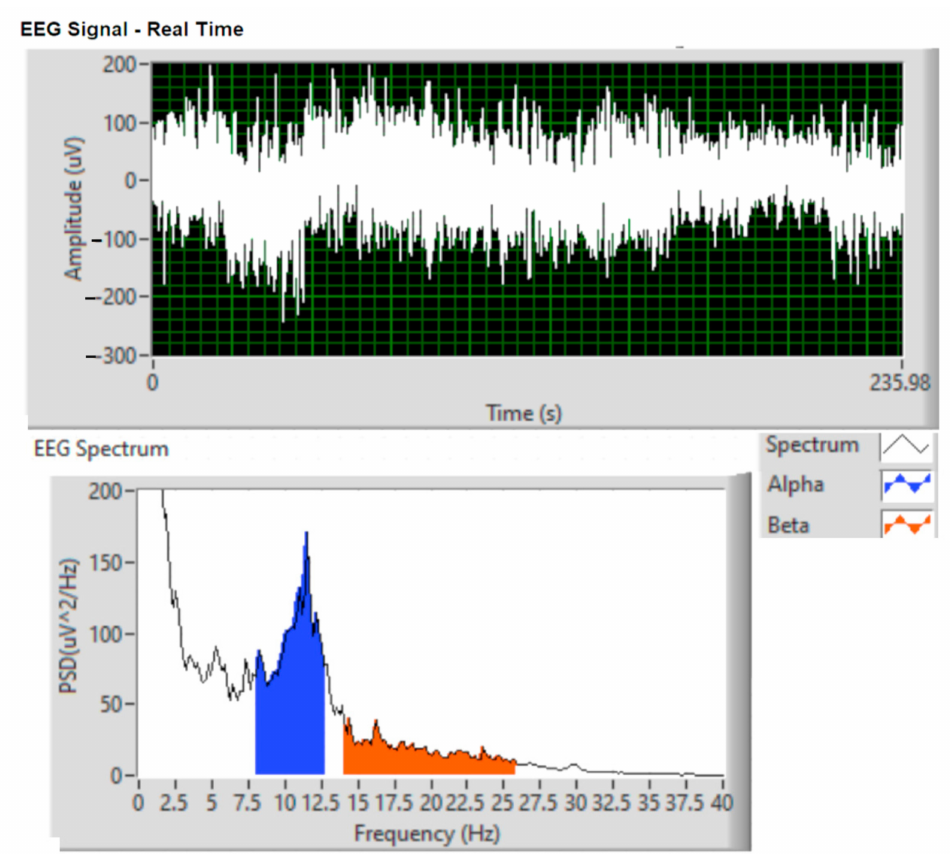
Figure 15. Frequency spectrum for alpha and beta brain waves when eyes are open.